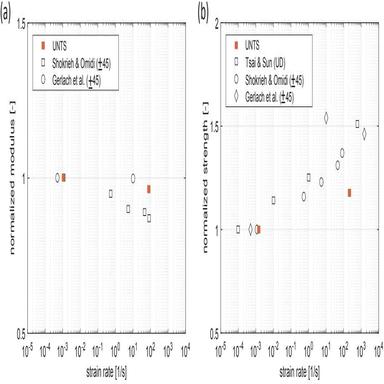
Normalized (a) in-plane shear modulus and (b) in-plane shear strength as a function of the strain rate, and comparisons with literature.